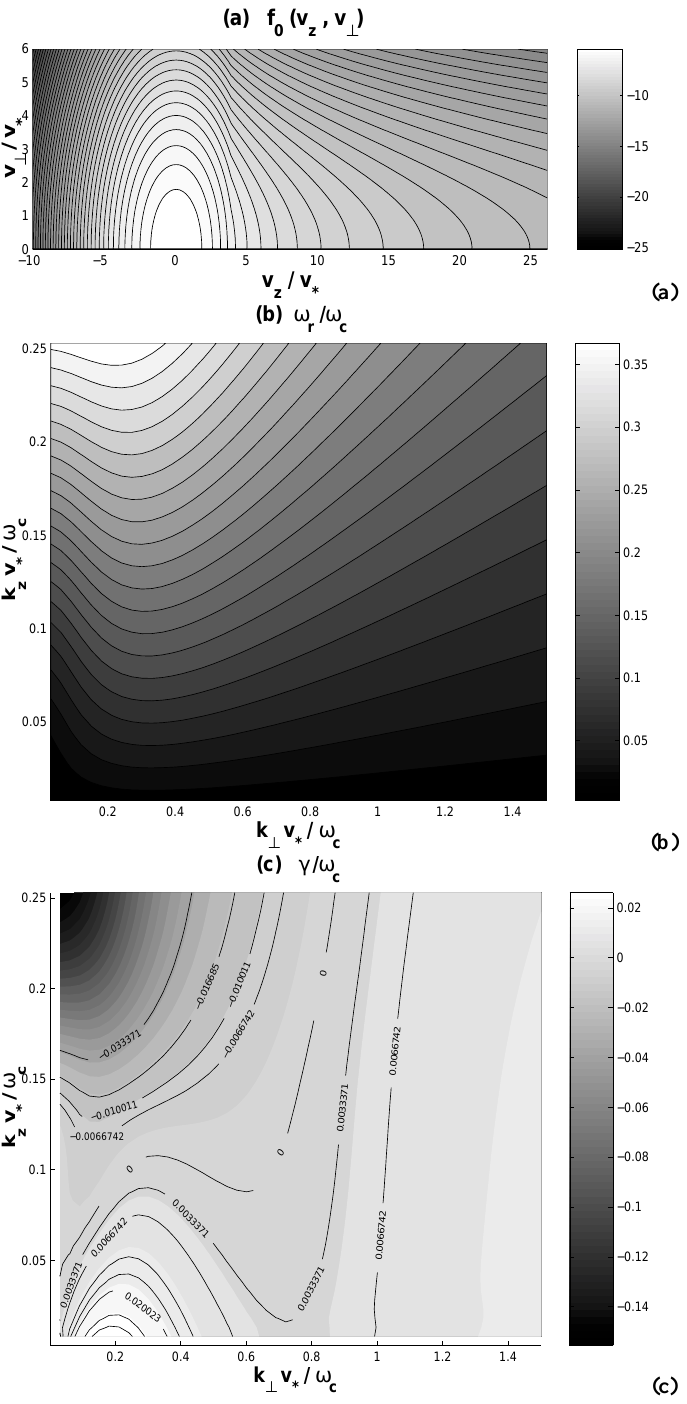
Fig. 1. Numerical calculations for solar wind plasma conditions: contour lines of constant level of (a) the electron velocity distribution f 0 (v,v ⊥ ) (in arbitrary units) as a function of the normalized parallel and perpendicular velocities v z /v ∗ and v ⊥ /v ∗ , (b) the normalized frequency ω r /ω c as a function of the normalized parallel and perpendicular wave numbers k z v ∗ /ω c and k ⊥ v ∗ /ω c , and (c) the normalized growth rate γ/ω c as a function of k z v ∗ /ω c and k ⊥ v ∗ /ω c . The solar wind parameters are: ω p /ω c ’ 167 , ω c / 2 π ’ 150Hz, ω p / 2 π ’ 25kHz, T e ’ 10eV, T e /T i ’ 2 . For (c), the values of the calculated growth rates are indicated on the